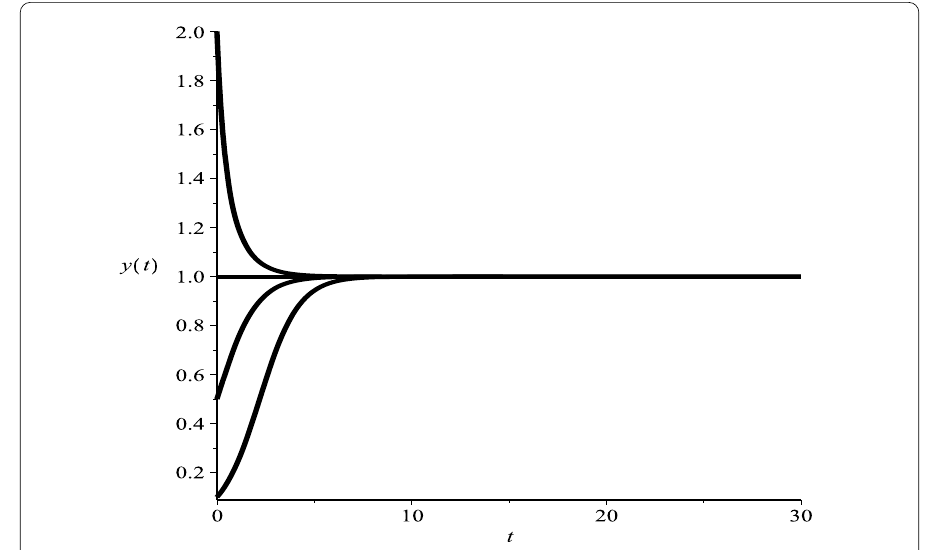
Figure 7 Dynamic behaviors of the third component y ( t ) of system (4.1), here we take d = 2 and the initial conditions ( x 1 (0), x 2 (0), y (0)) = (0.5,0.5,0.5), (0.1,0.1,0.1), (1,1,1), and (2,2,2),